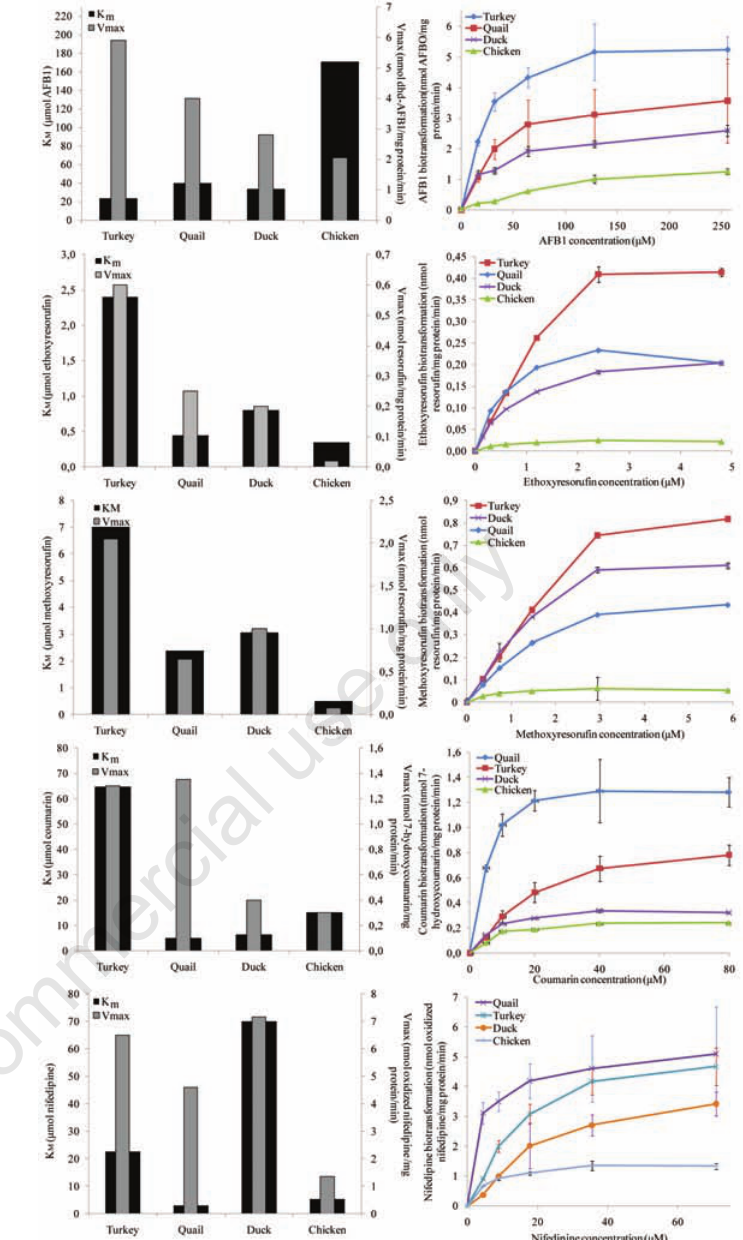
Figure 1. Enzymatic constants K and Vmax obtained by nonlinear regression (left) and m Michaelis-Menten kinetics obtained from experimental data (right) for CYP avian orthologs. Enzyme activities from top to bottom are AFB1 epoxidase, 7-ethoxyresorufin- O-deethylase (EROD), 7-methoxyresorufin-O-deethylase (MROD), coumarin 7-hydrox- ylase and nifedipine oxidase. Enzymatic constants KM and Vmax are graphed in black and gray, respectively. In Michaelis-Menten kinetics each point represents the mean ± standard deviation of 6 Table 1. Orthogonal contrasts of enzyme kinetics among four commercial poultry species. Only values that are statistically different (P<0.05) are shown. Substrate